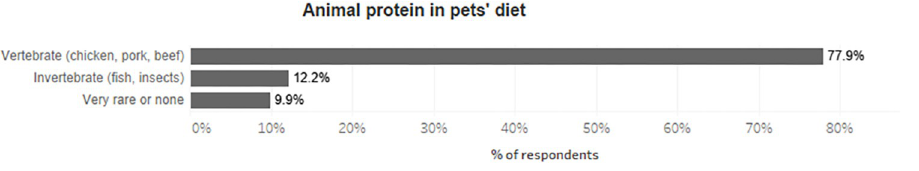
Fig 2. Animal protein in pets’